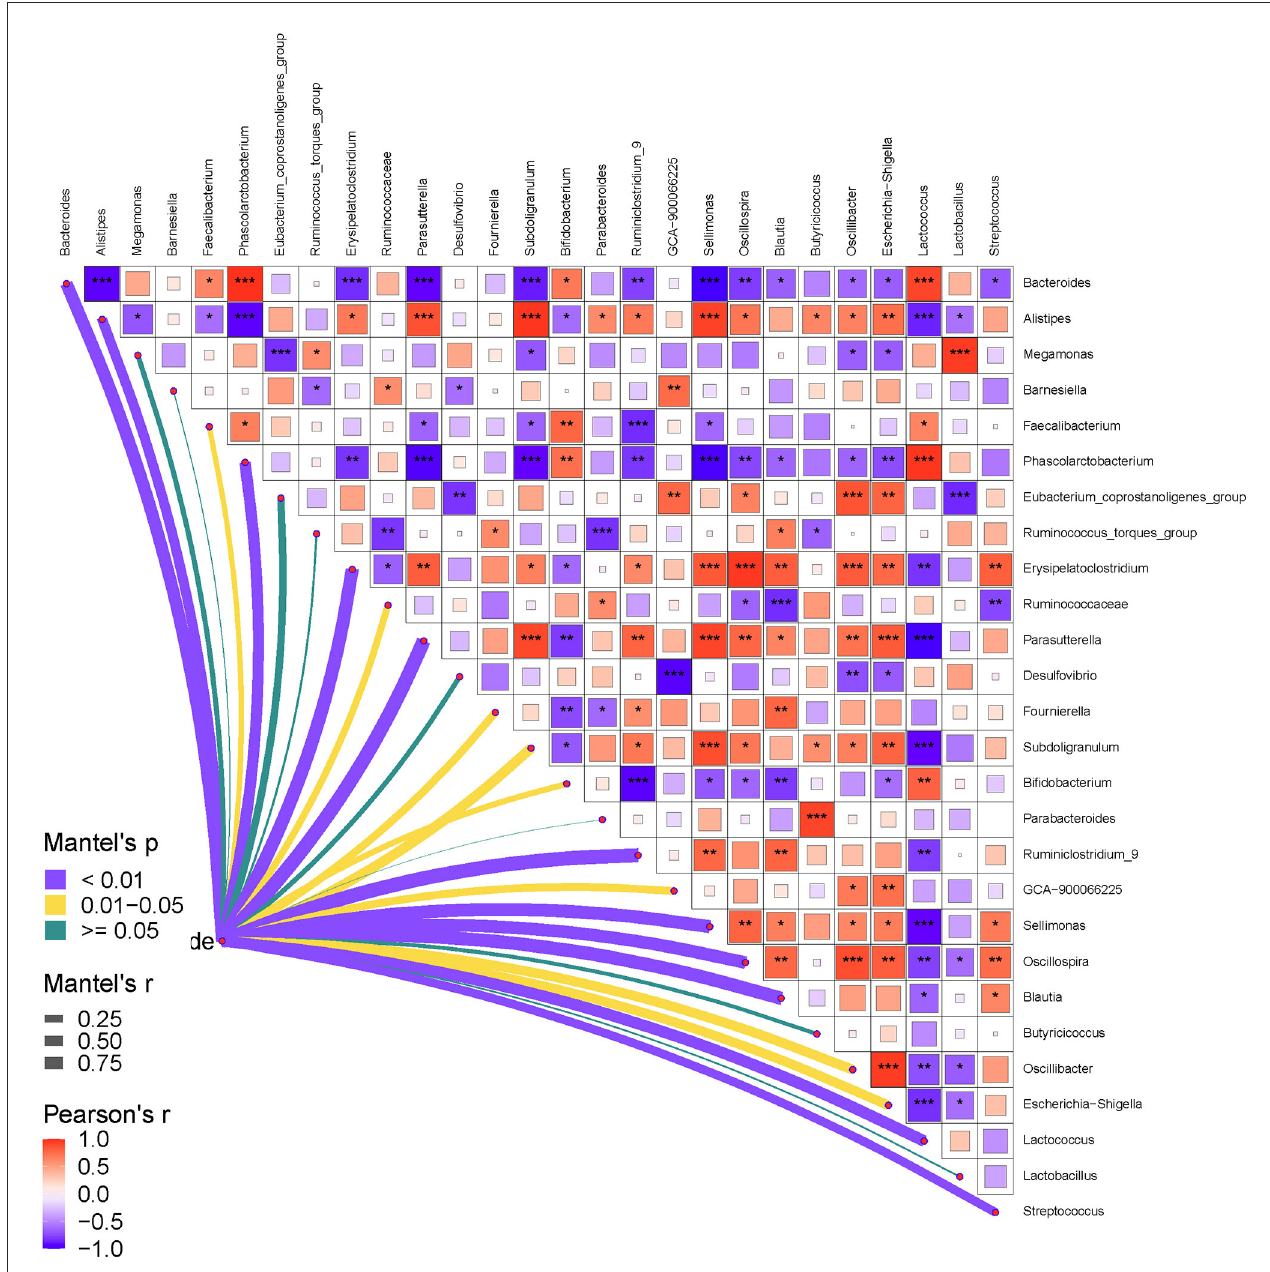
FIGURE6 Pearson correlation heatmap analysis of the RFI and the relative abundances of cecal bacteria (genera level). The red color represents a positive correlation, while the blue color represents a negative correlation. The * symbol denotes a significant correlation (0.35 < |r| < 0.55, P < 0.05). The ** symbol denotes (0.55 < |r| < 0.75, P < 0.01). The *** symbol denotes (|r| > 0.75, P <